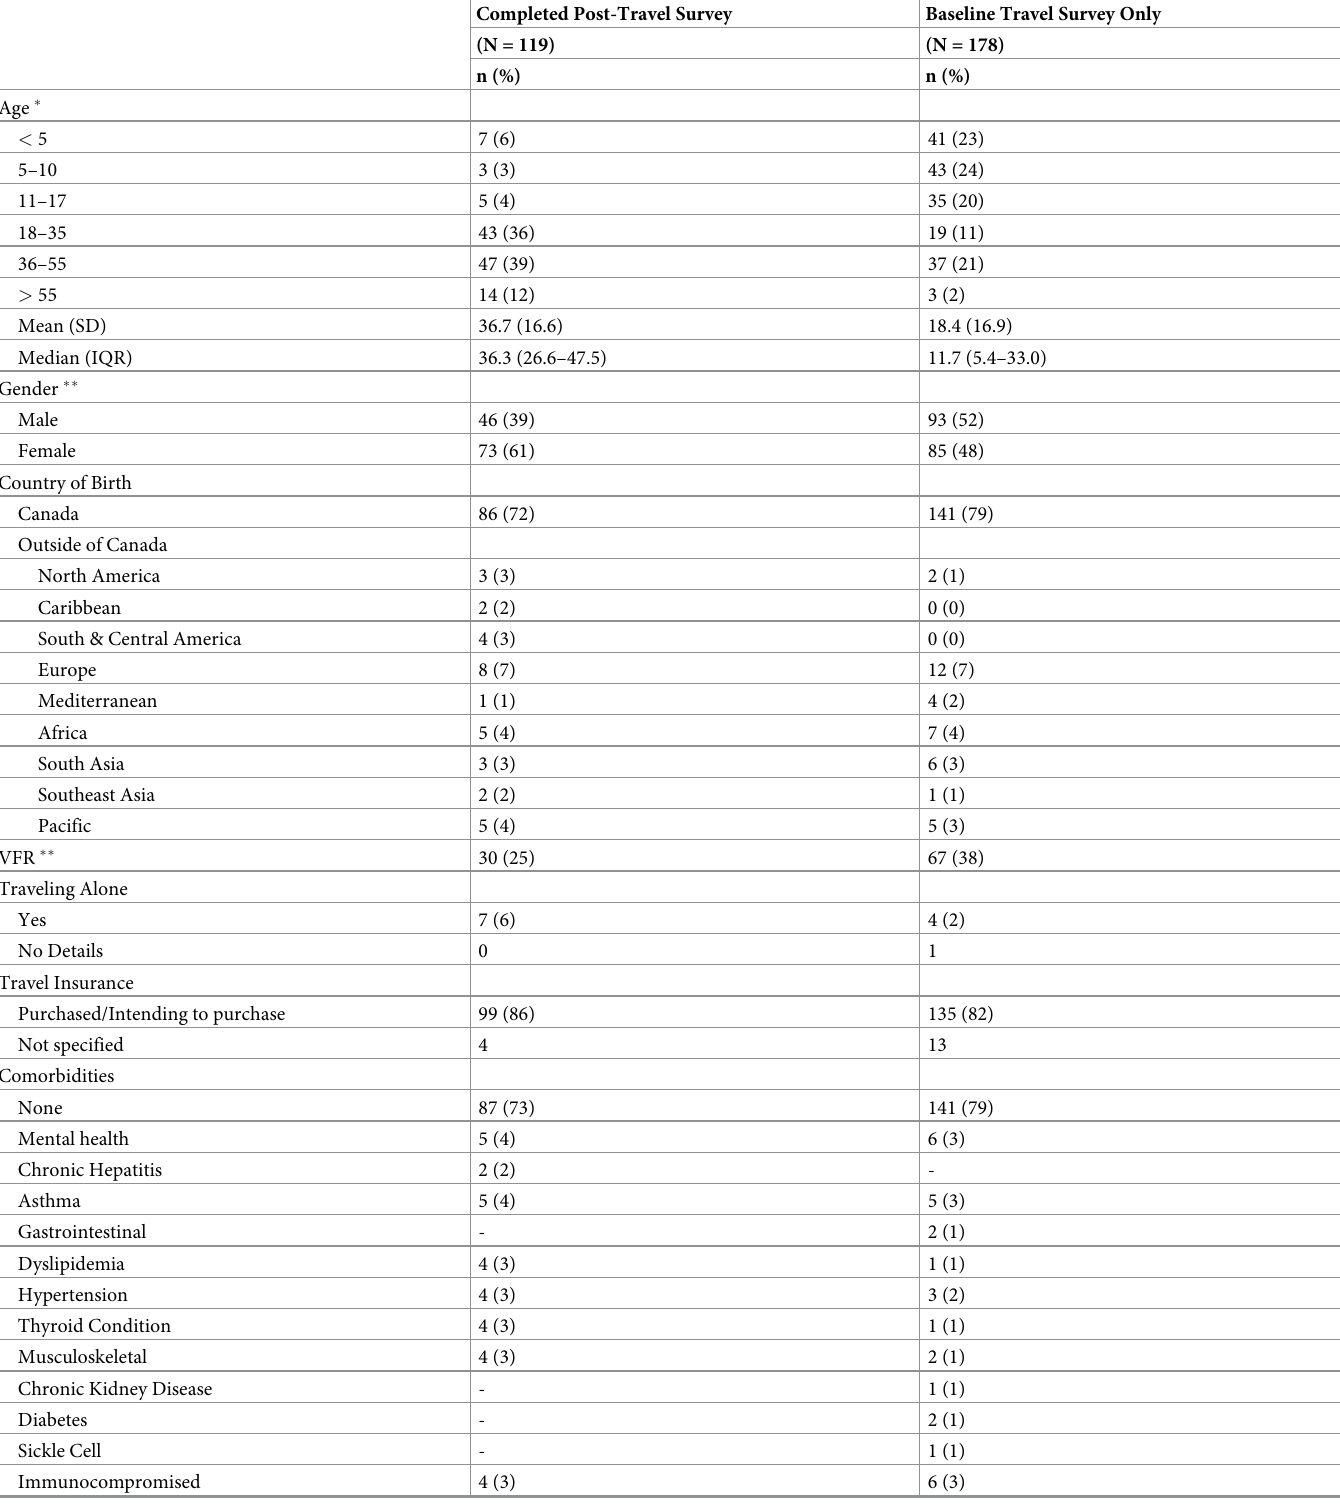
Table 2. Demographics and planned travel characteristics of travelers at the SickKids Travel Clinic for October 2014 to November